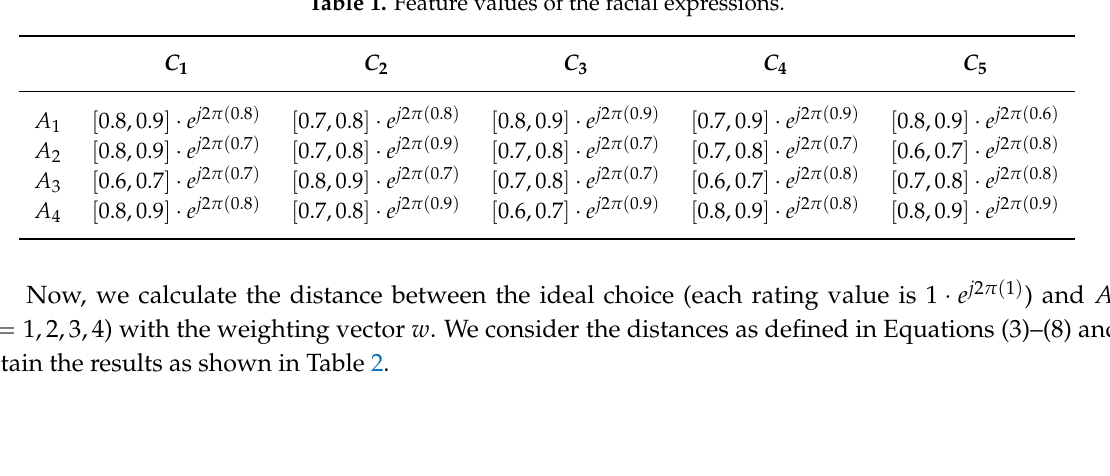
Table 1. Feature values of the facial